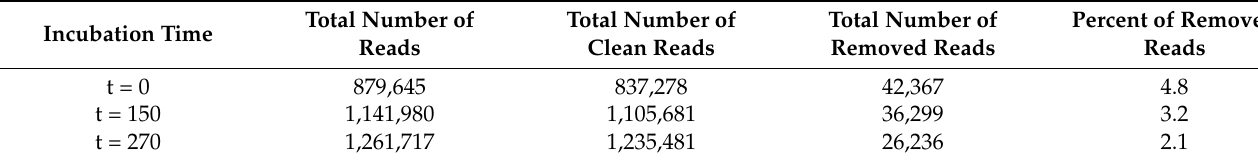
Table 2. Number of NGS reads at different time points. The table shows the total number of reads obtained after NGS sequencing, the number of clean reads used for data analysis, and the number of removed reads after filtering.